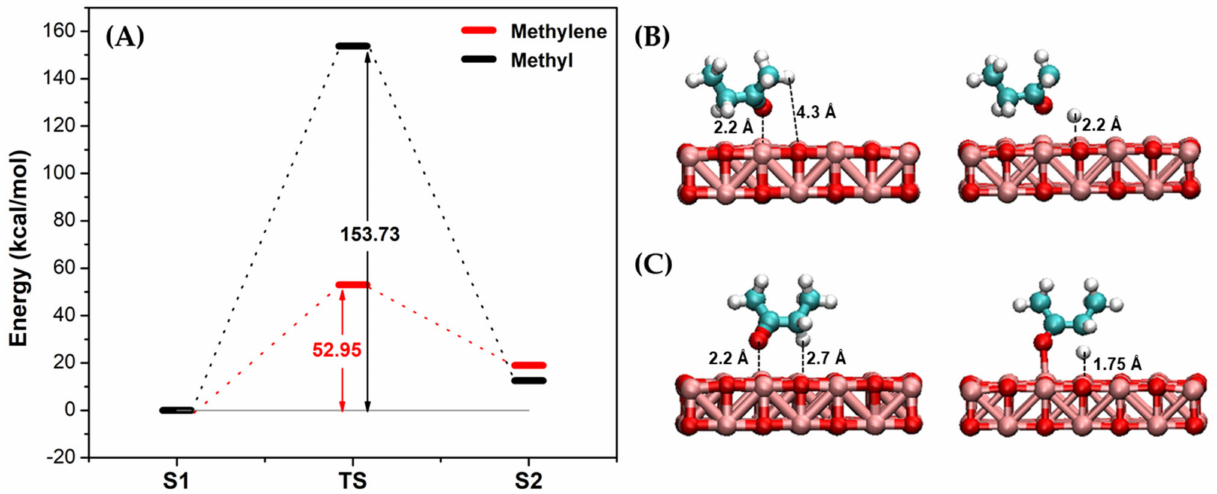
Figure 10. ( A ) Energy profile of 2-butanone enolization to generate methylene (red line) and methyl (black line) enolates onto MgO(100) surface, and the stable molecular structures of adsorbed ( B ) methyl and ( C ) methylene enolates, obtained from DFT calculation with M06-2X/6-31G basis